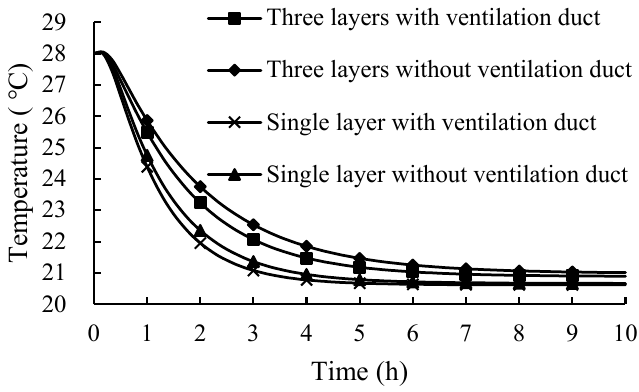
Figure 15. Temperature variations of the fresh tea leaves with different stacks.